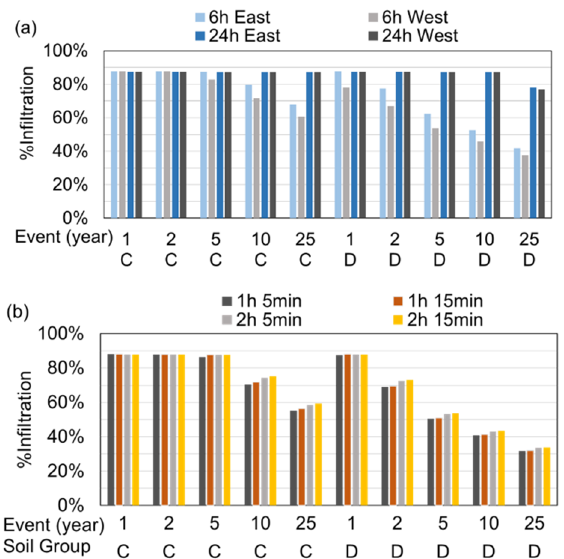
Figure 2. ( a ) Percent infiltration on soil groups C and D for 6- and 24-h events with east and west precipitation distributions at all frequencies. Results for soil groups A and B show no differences between east and west. ( b ) Percent infiltration for 1- and 2-h events with 5- and 15-min precipitation time steps. Results for soil groups A and B show no differences between east and west.